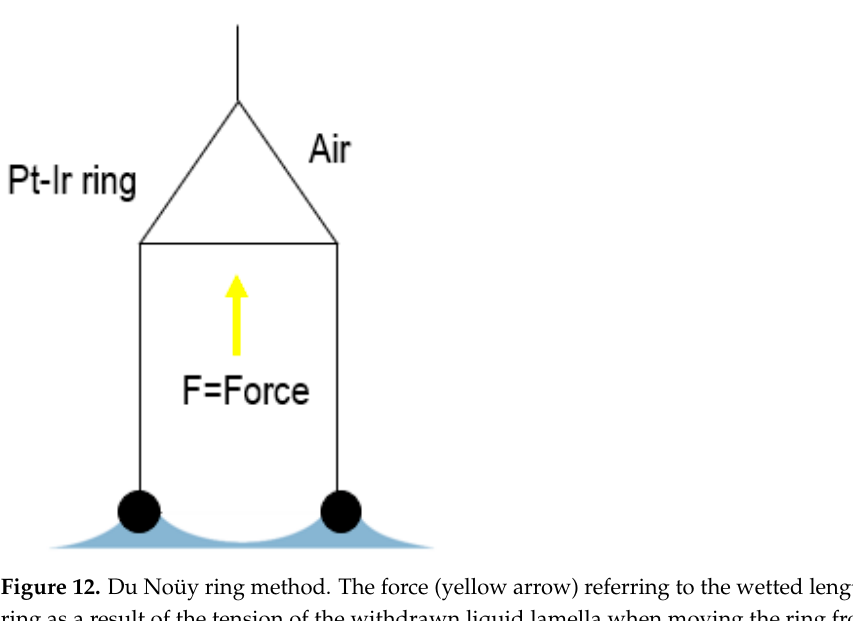
13 of 26 Figure 11. Emulsification index. (A) Kerosene—negative control; (B) emulsification of kerosene by culture supernatant; (C) diesel oil—negative control; and (D) emulsification of diesel oil by culture supernatant. Source: [95]. 5.9. Tensiometric Measurement Measurement of surface tension using a tensiometer is one of the most common